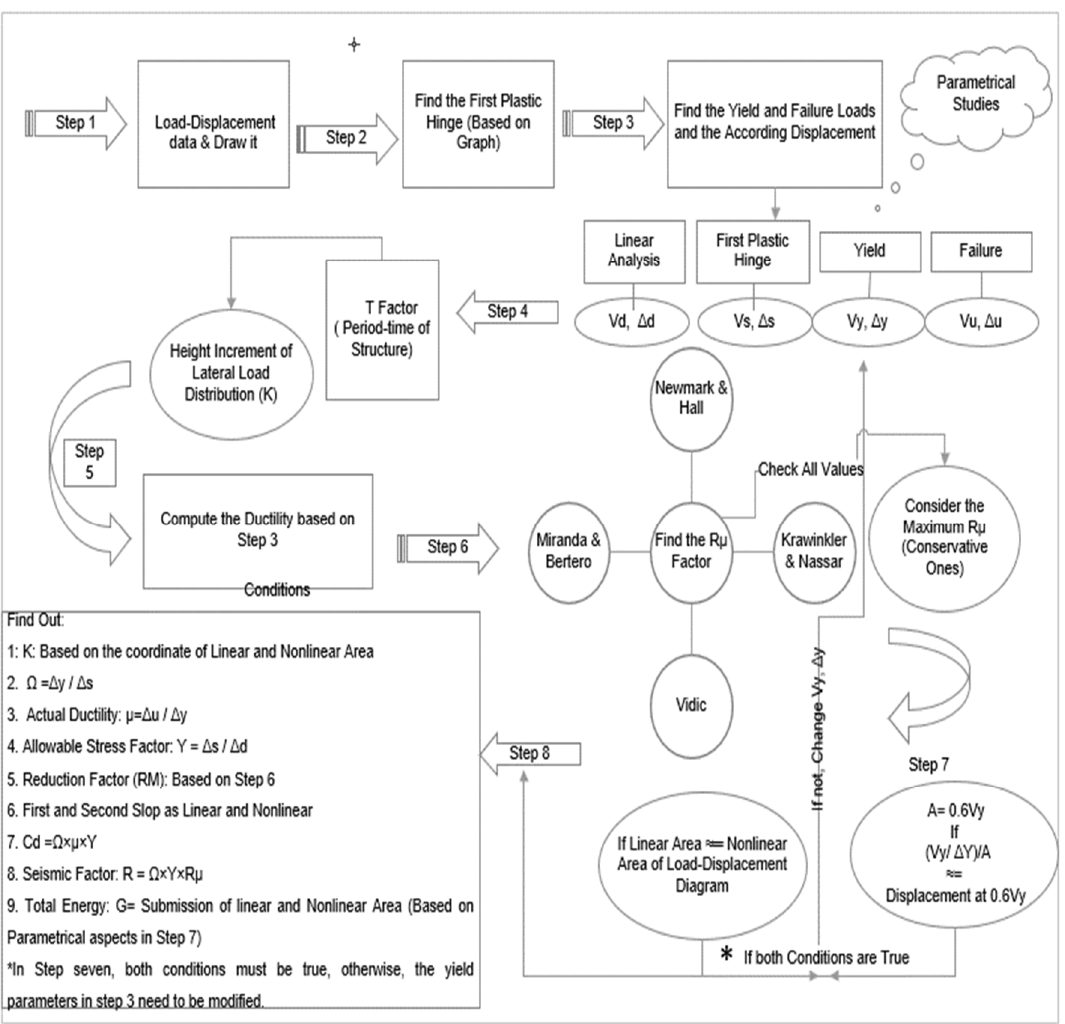
Figure 4. Flowchart for Seismic Calculation.